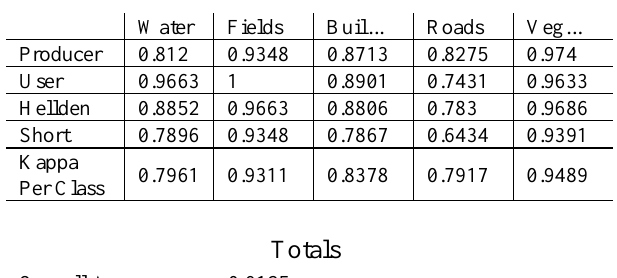
Figure 19. Ground truth used to validate the classification obtained.